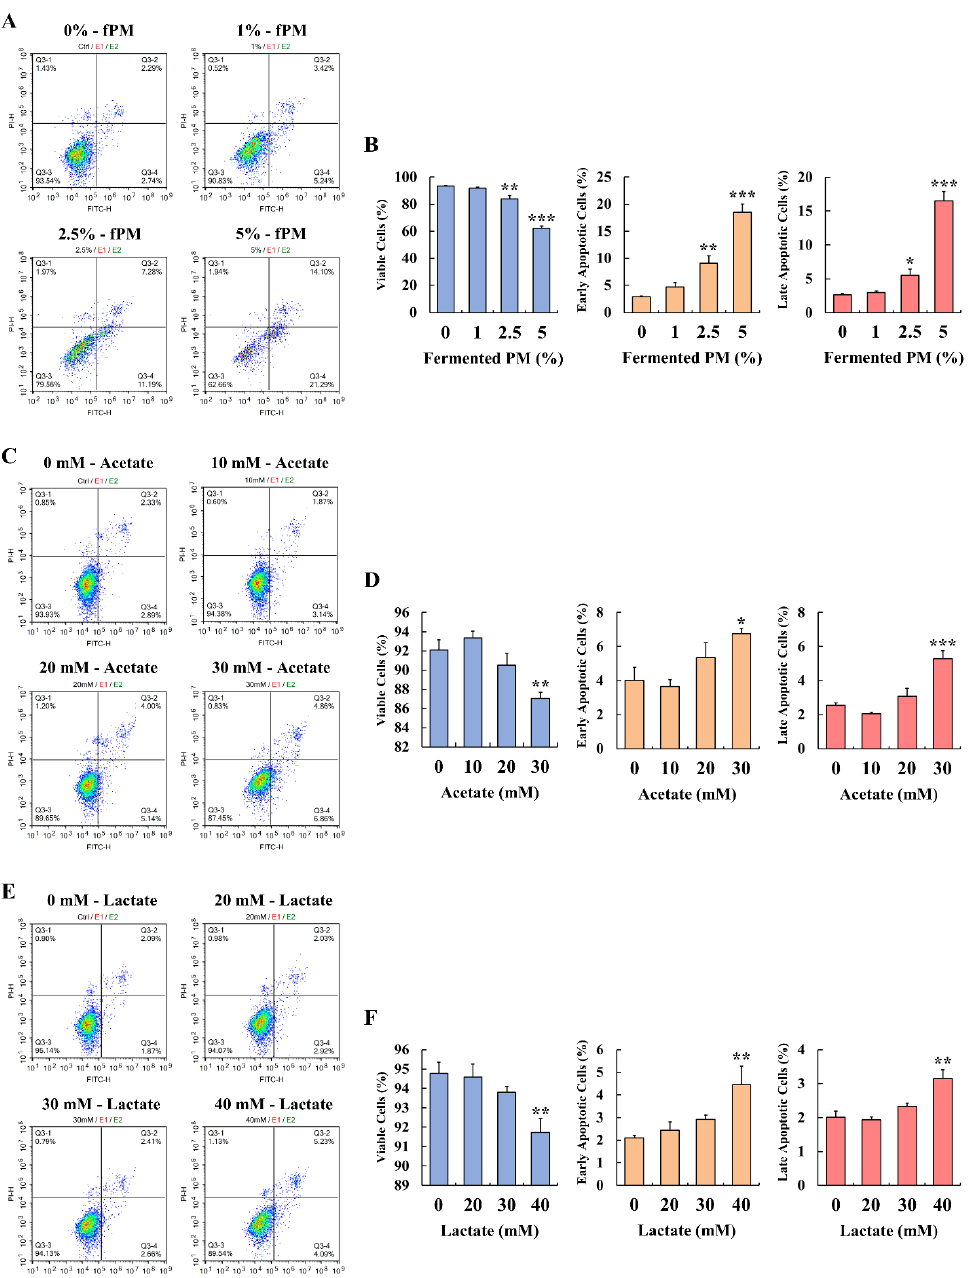
Figure 5. Effects of fermented PM (fPM), acetate, and lactate on cell viability and apoptosis in Caco-2 cells. Flow cytometry scatter plots of propidium iodide (y-axis) versus annexin V-fluorescein isothiocyanate (x-axis) on treatment with ( A ) fermented PM, ( C ) acetate, and ( E ) lactate in Caco-2 cells. Images of flow cytometry scatter plots are representative of three independent experiments. Percentage of viable cells, early apoptotic cells, and late apoptotic cells treated with ( B ) fermented PM, ( D ) acetate, and ( F ) lactate in Caco-2 cells. The cells were treated with fermented PM (0, 1, 2.5, and 5%), acetate (0, 10, 20, and 30 mM), and lactate (0, 20, 30, and 40 mM) for 48 h ( n = 3 wells per groups). Results are expressed as mean ± standard error ( n = 3). * ( p < 0.05), ** ( p < 0.01), and *** ( p < 0.001) indicate significant differences compared with the control (0% and 0